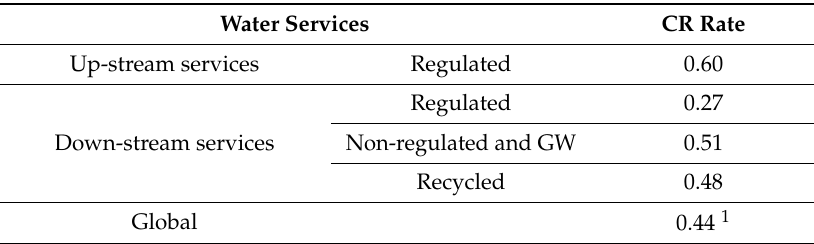
Table 8. Global cost-recovery rate by water